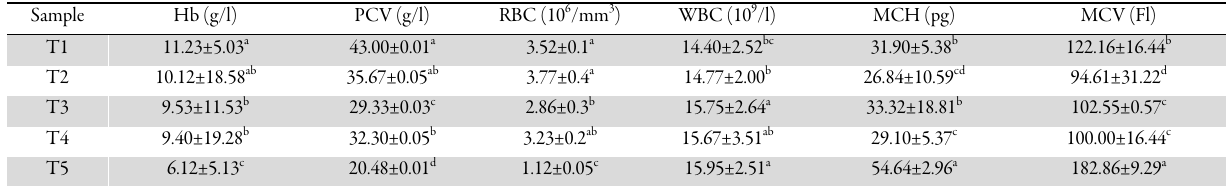
Mean with the same superscript are not significantly different Table 8. Haematological parameters of the test and control fish fed with dried poultry waste for 12 weeks Sample